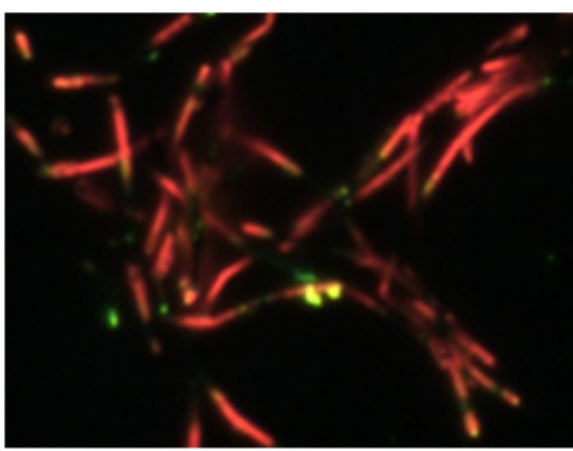
Figure 6. Luminescence CCD images of bundle of ammonia vapor-treated barcode NW.